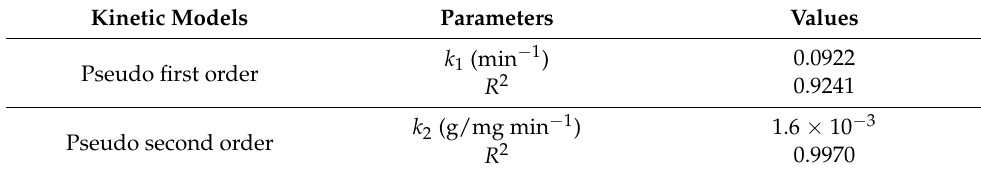
Figure 9. Adsorption kinetics study for the pseudo first and second orders. Table 1. Adsorption kinetics parameters of the oil into the clay-alginate-IL beads.